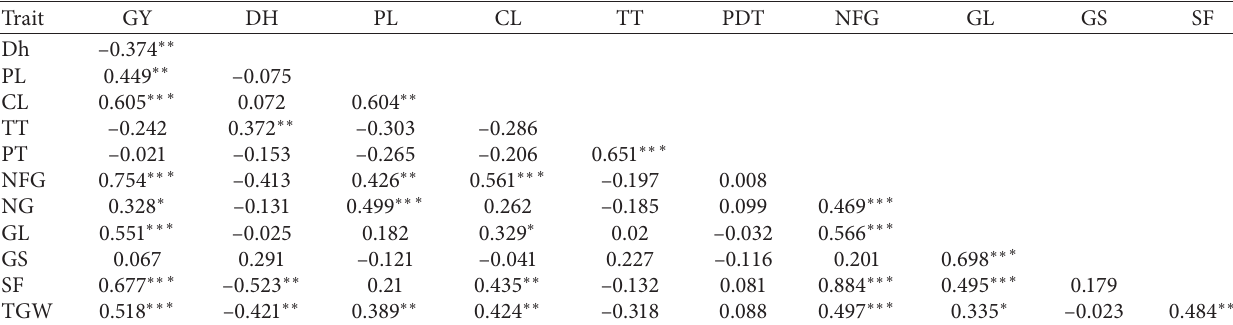
Table 6: Correlation coefficient of grain yield and other component